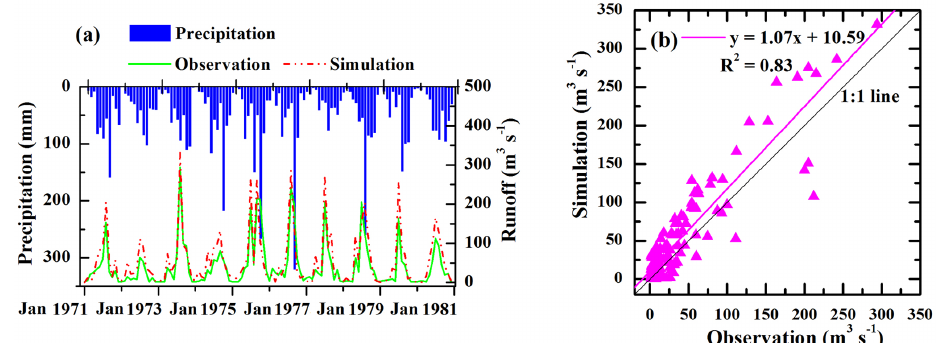
Figure 5. Comparison of observed and simulated runoff at the monthly scale in the Jinghe River basin during the calibration period from 1971 to 1980. Panel (b) is redrawn from Qiu et al. (2011).